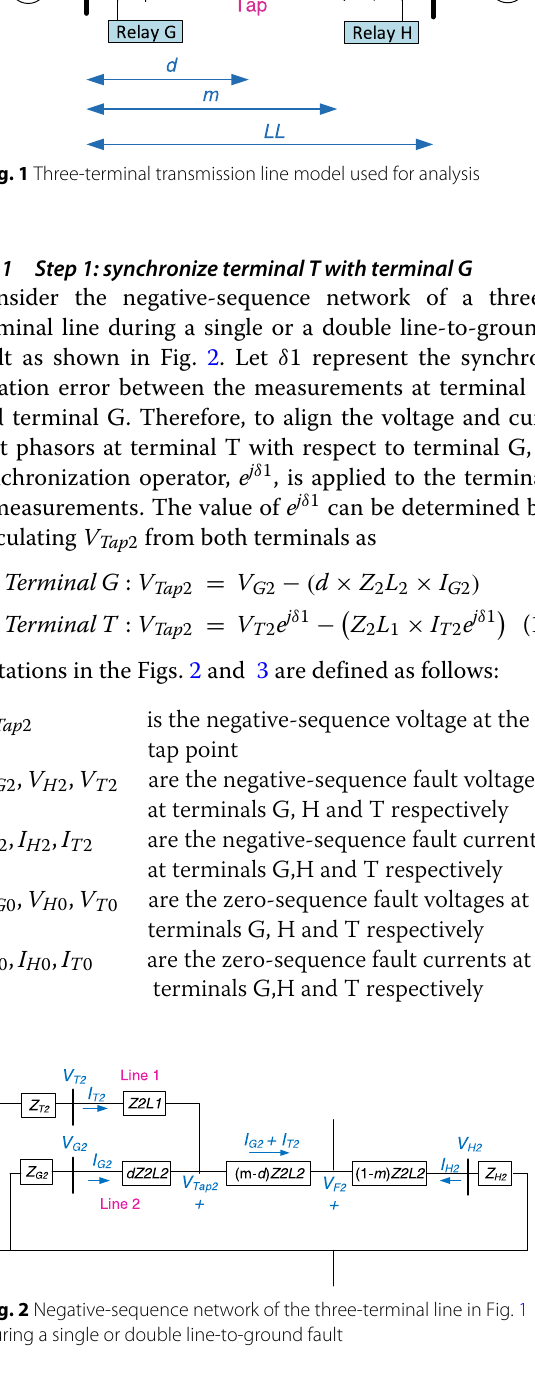
Fig. 3 Zero-sequence network of the three-terminal line in Fig. 1 during a single or double line-to-ground fault